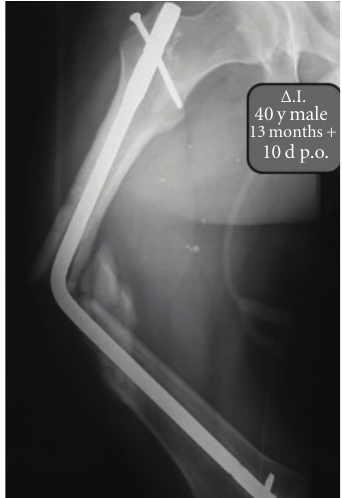
Figure 3: Radiographic image showing refracture of the femoral shaft and a bending deformation of the intramedullary